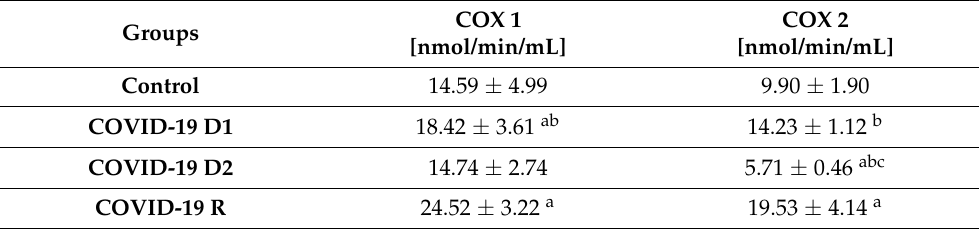
Table 4. Changes in the activity of COX-1 and COX-2 in the plasma of healthy subjects ( n = 20) [Control] , first subgroup of deceased COVID-19 patients ( n = 15) [COVID-19 D(1)] , second subgroup of deceased COVID patients ( n = 5) [COVID-19 D(2)] and recovered COVID-19 patients ( n = 20) [COVID-19 R] .